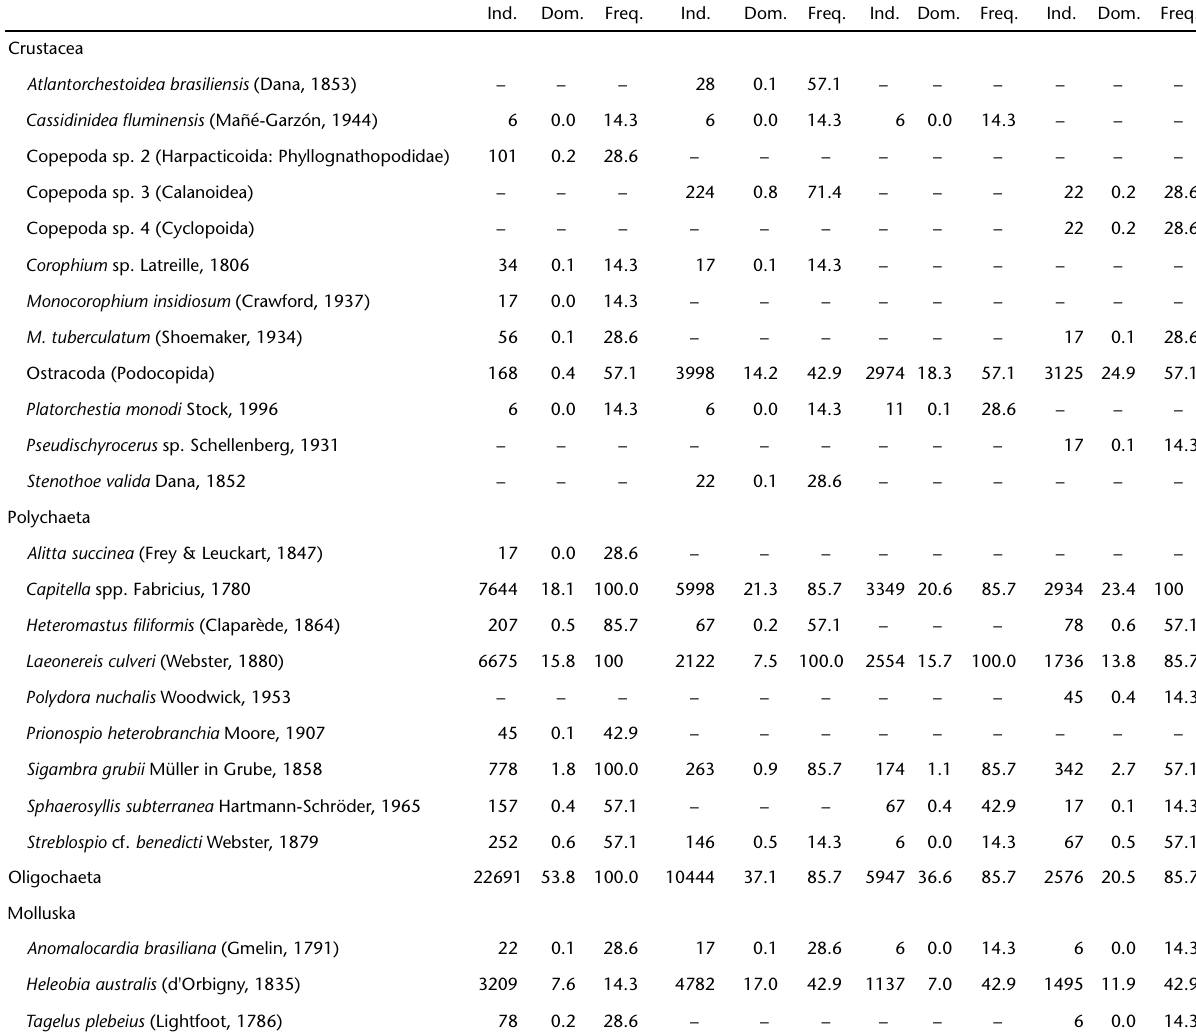
Table V. Number of individuals (ind.m -2 ), specific dominance (%) and relative frequency (%) of the benthic macrofauna found in Saquarema-Jaconé lagoonal system per sampling period. Rare species were removed for simplification and are mentioned in text. Ind. Dom.